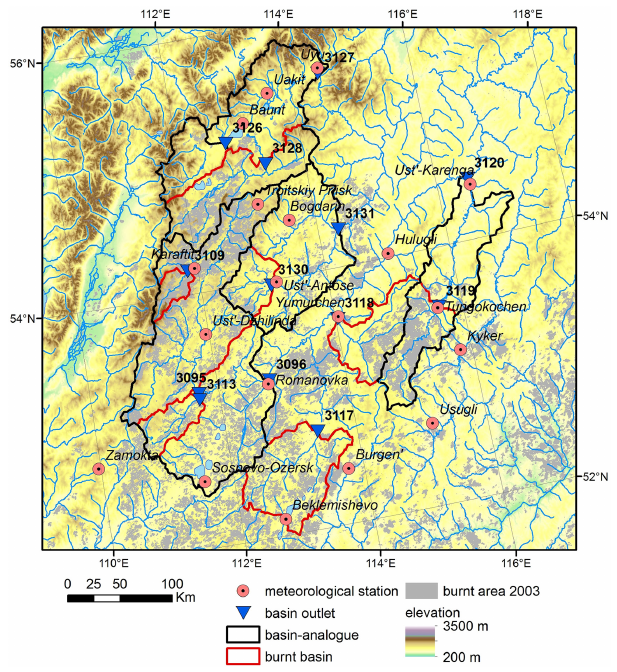
Figure 1. The scheme of studied area.